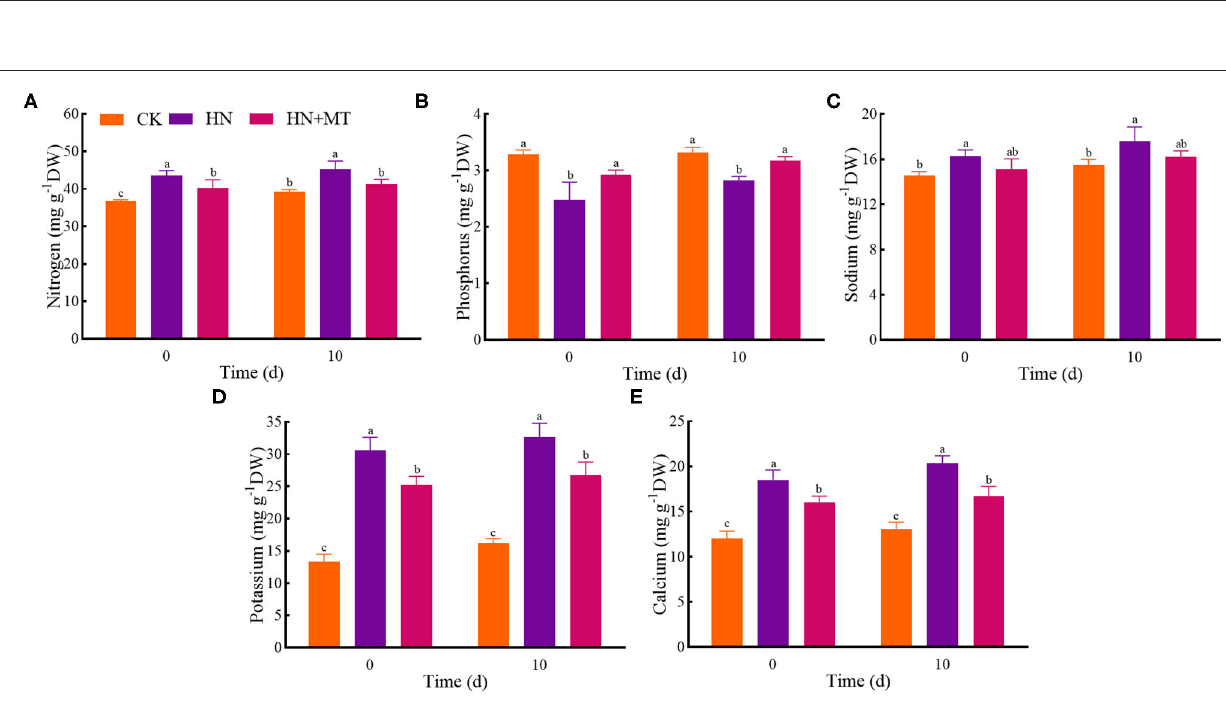
Frontiers in Plant Science |